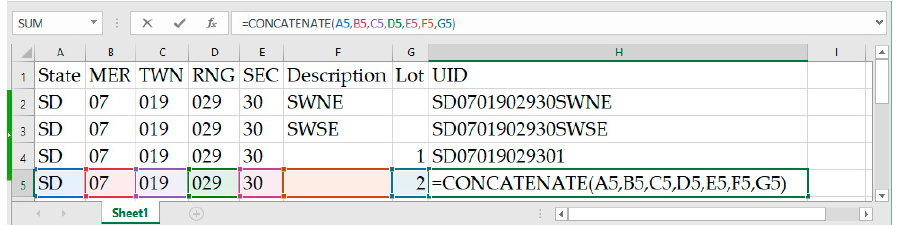
Figure 7. Transcribed allotment ledger books in the spreadsheet. Concatenating land description information to generate unique IDs for each parcel. Note the similarity between the UID column in the spreadsheet with the PLSS default SECDIVID attribute field in Figure 8.